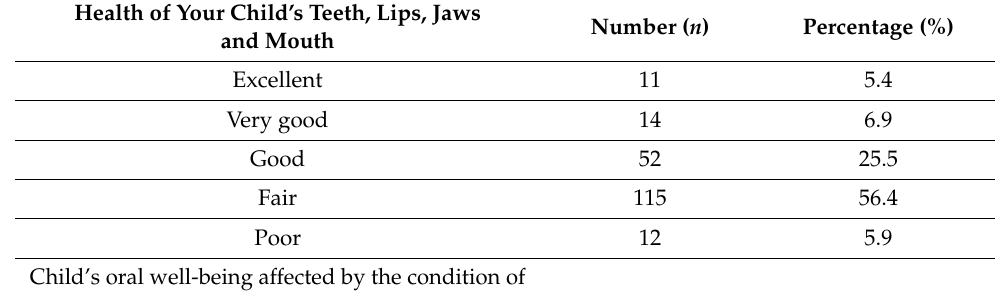
Table 2. Child’s oral health and well-being from Parental Caregiver Perception Questionnaire